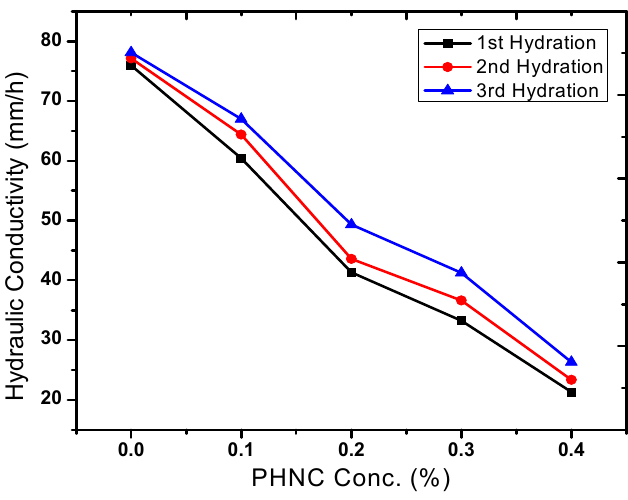
Figure 10. Effect of PHNC on soil hydraulic conductivity.